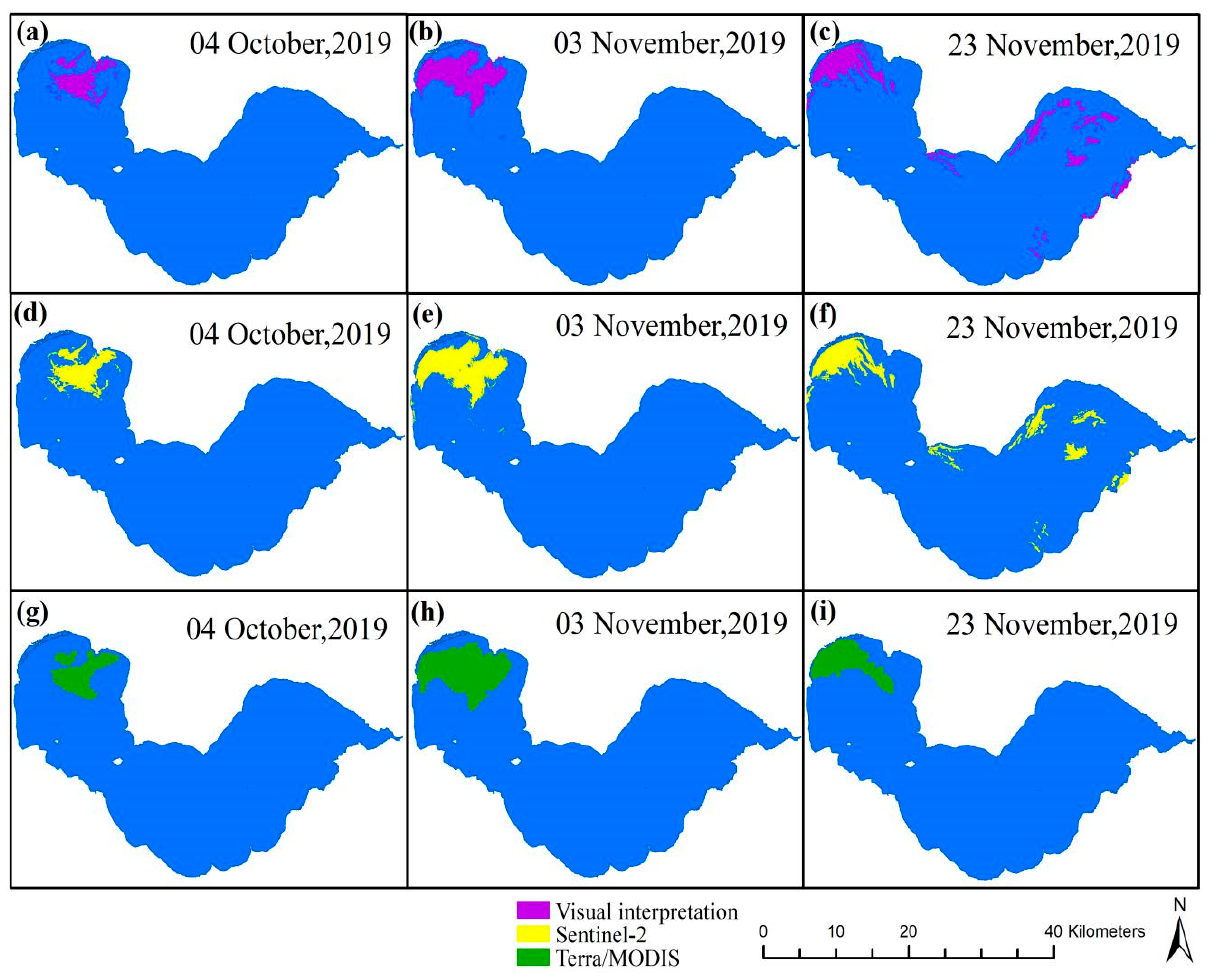
Figure 16. Comparison of the extraction results among Sentinel-2, Terra/MODIS, and visual interpretation: ( a,d,g ) Results of HAB extraction from Visual interpretation, Sentinel-2, Terra/MODIS on October 4, ( b,e,h ) Results of HAB extraction from Visual interpretation, Sentinel-2, Terra/MODIS on November 3, ( c,f,i ) Results of HAB extraction from Visual interpretation, Sentinel-2, Terra/MODIS on November 23.